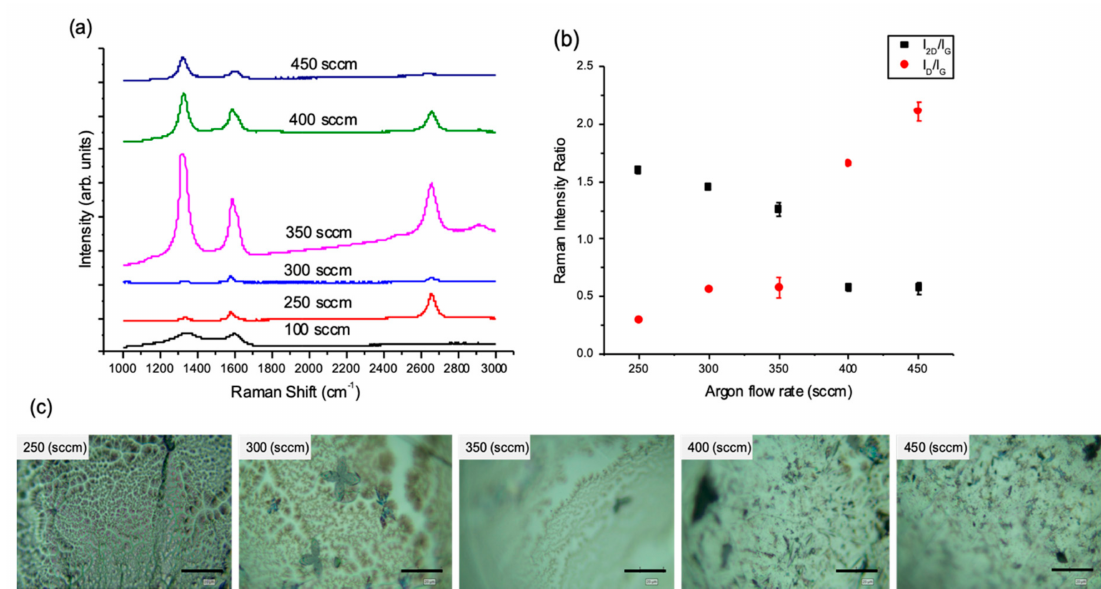
Figure 3. ( a ) Raman spectra of graphene grown on liquid Sn showing the e ff ect of changing the Ar flow rate. ( b ) Average Raman intensity ratio I 2D / I G and I D / I G values vs. the Ar flow rate based on maps data. (Error bars are smaller than some data points). ( c ) Optical images of the grown graphene films (scale bar: 20 µ m), some blurriness is due to the surface curvature of the solidified Sn after melting (APCVD, T = 1120 ◦ C, 25 H 2 / (100–450) Ar / 5 CH 4 sccm, t = 5